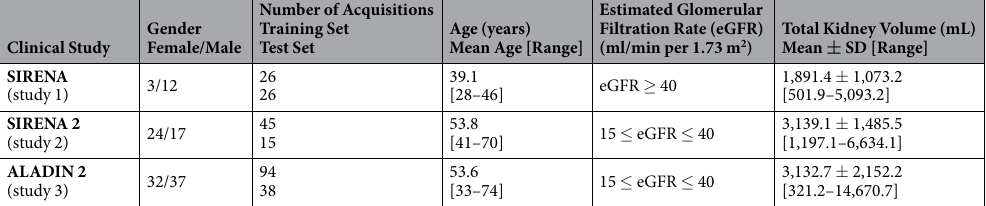
Table 1. Demographics and Clinical Characteristics of ADPKD Patients. ADPKD patients (n = 125) with baseline and follow-up CT acquisitions (training set = 165, test set = 79) included in our